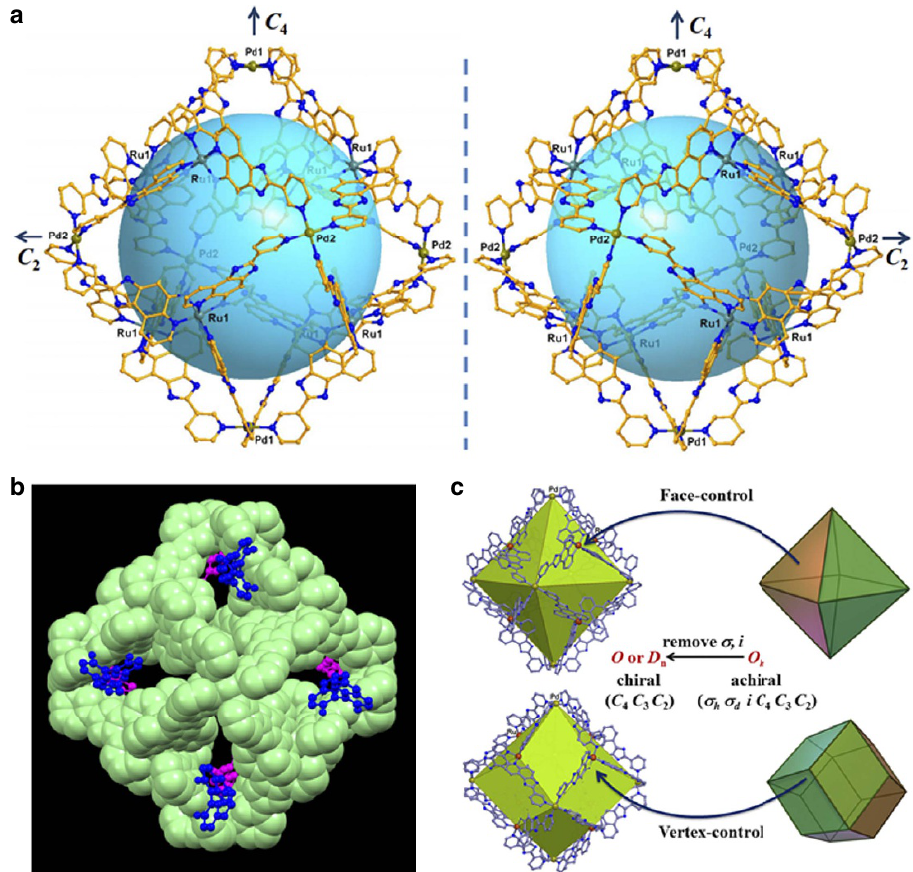
Figure 2 | Crystal structures. ( a ) A pair of D 4 -symmetric homochiral D - and L -MOCs-16 showing DDDDDDDD and LLLLLLLL configurations of eight RuL 3 metalloligands whereas LLLLLL - and DDDDDD -configurations of six Pd-Py 4 subcomponents. ( b ) A D -MOC-16 cage (in space-filling mode) capturing eight S -BINOL guests (in ball-and-stick mode) on the windows pockets. ( c ) The demonstration how to form D 4 L -MOC-16 from O h regular polyhedra by introducing eight L -3 metalloligands on the faces of an octahedron, or, on the C 3 vertices of a rhombic dodecahedron, to reduce molecular symmetry, and further direct D -arrangement of four pyridyl rings around six vertices of Pd